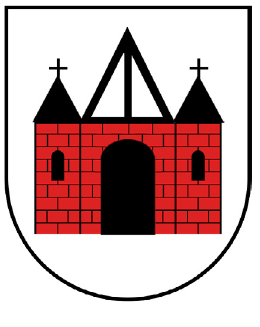
Figure 13. The former arms of